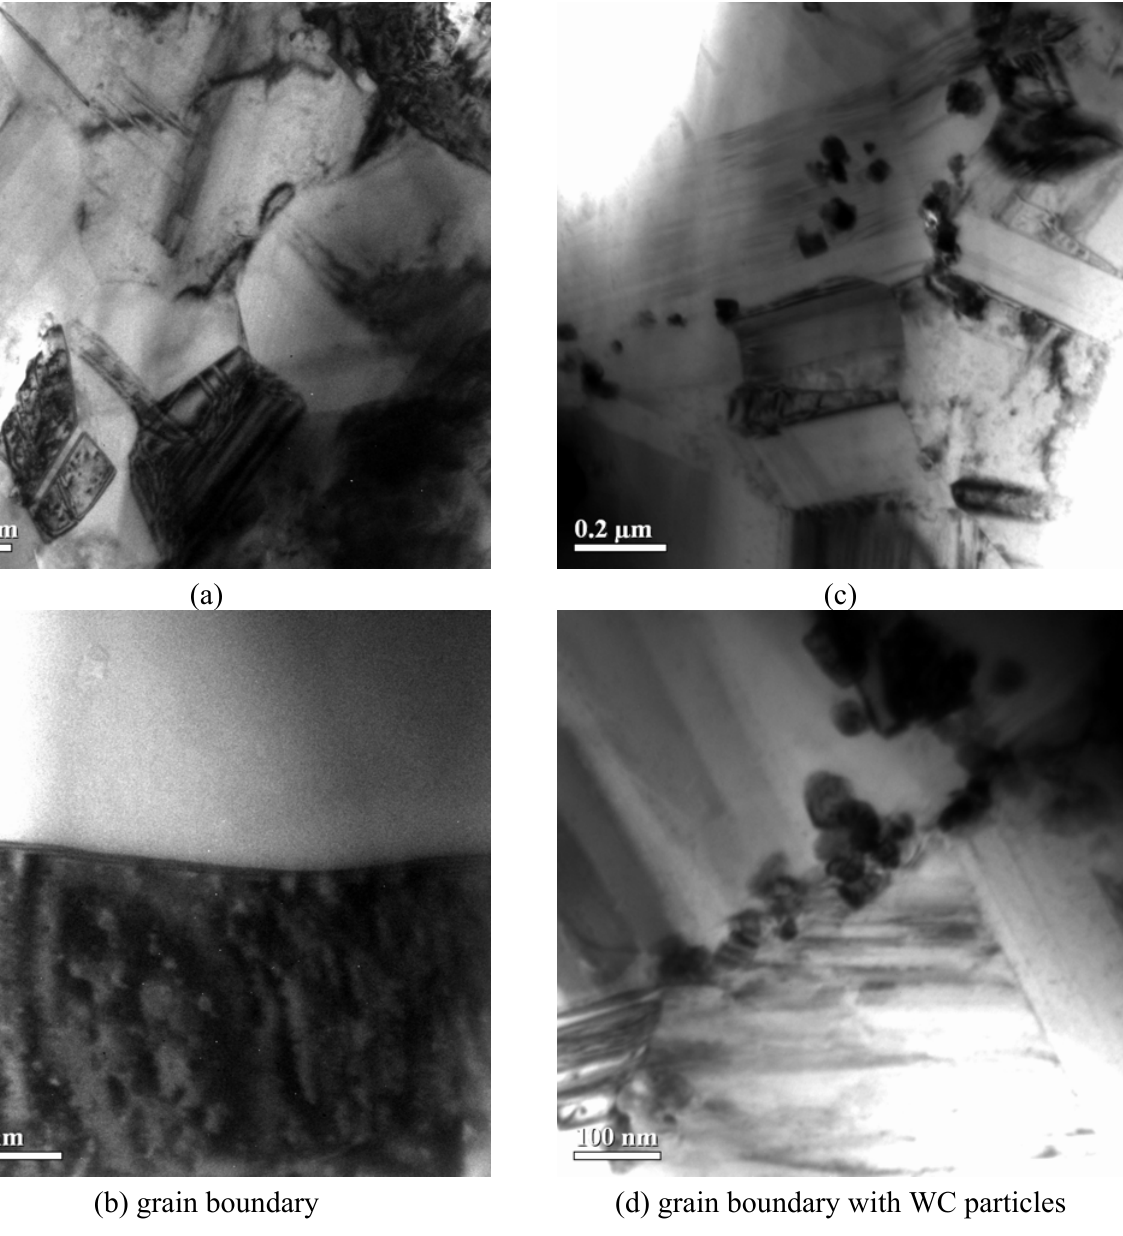
Figure 3. TEM images of sintered (a, b) pure Co and (c, d) Co–WC alloy.